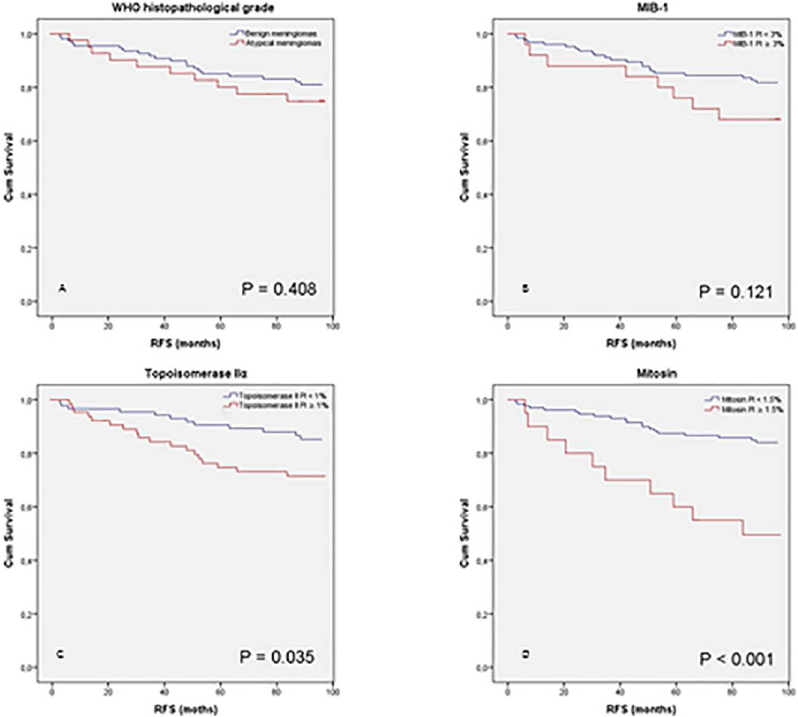
Fig 2. Kaplan-Meier curves and recurrence-free survival (RFS). Meningioma patients were stratified by optimalcutoff values revealed by receiveroperator characteristics (ROC). Histopathological grade (A), MIB-1 PI (B), topoisomerase II α (C), and mitosin (D). Topoisomerase II α and mitosin expressionwere demonstrated to be predictors of RFS, but no association was found with histopathological grade or